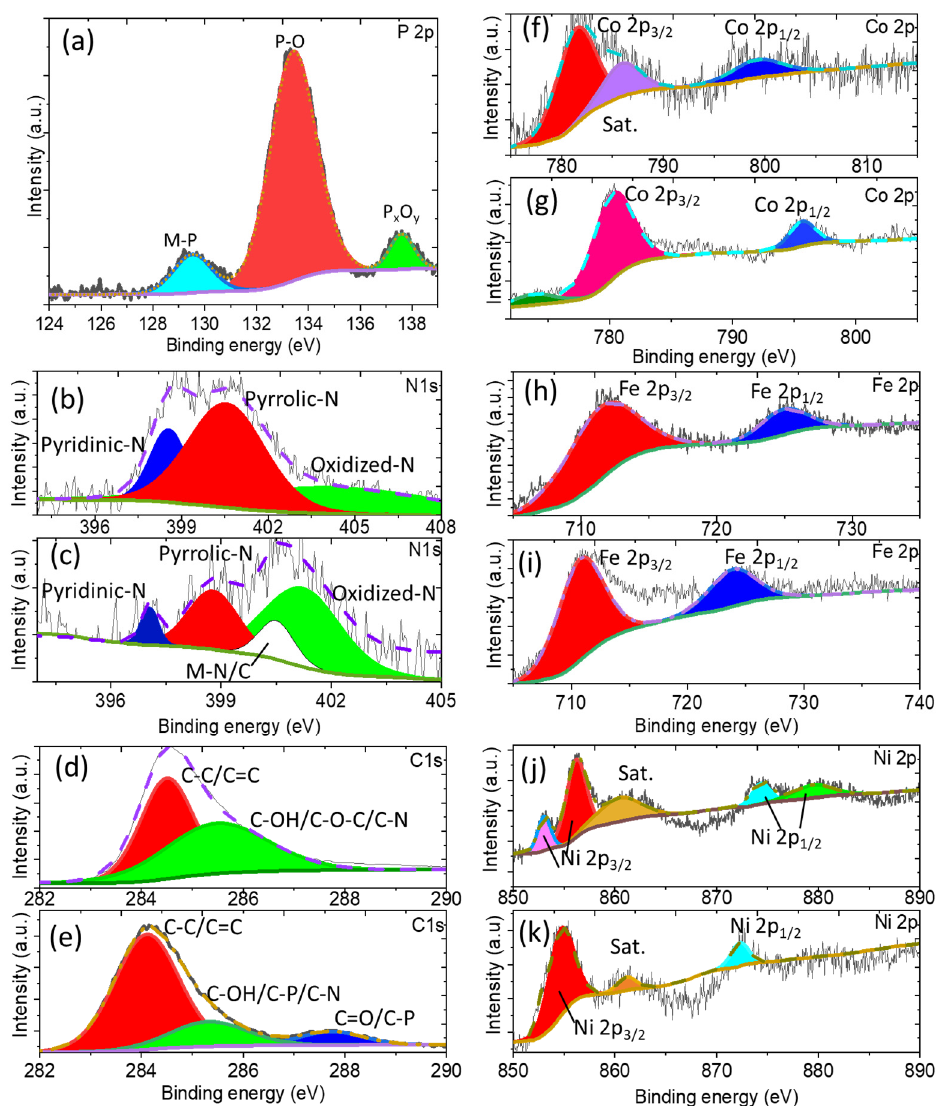
Figure 4. Deconvolution of high resolution XPS spectra for ( a ) phosphorus of P-NiFeCo/NC, ( b , c ) nitrogen of NiFeCo/NC and P-NiFeCo/NC, ( d , e ) carbon of NiFeCo/NC and P-NiFeCo/NC, ( f , g ) cobalt of P-NiFeCo/NC and NiFeCo/NC, ( h , i ) iron of P-NiFeCo/NC and NiFeCo/NC, and ( j , k ) nickel of P-NiFeCo/NC and NiFeCo/NC.